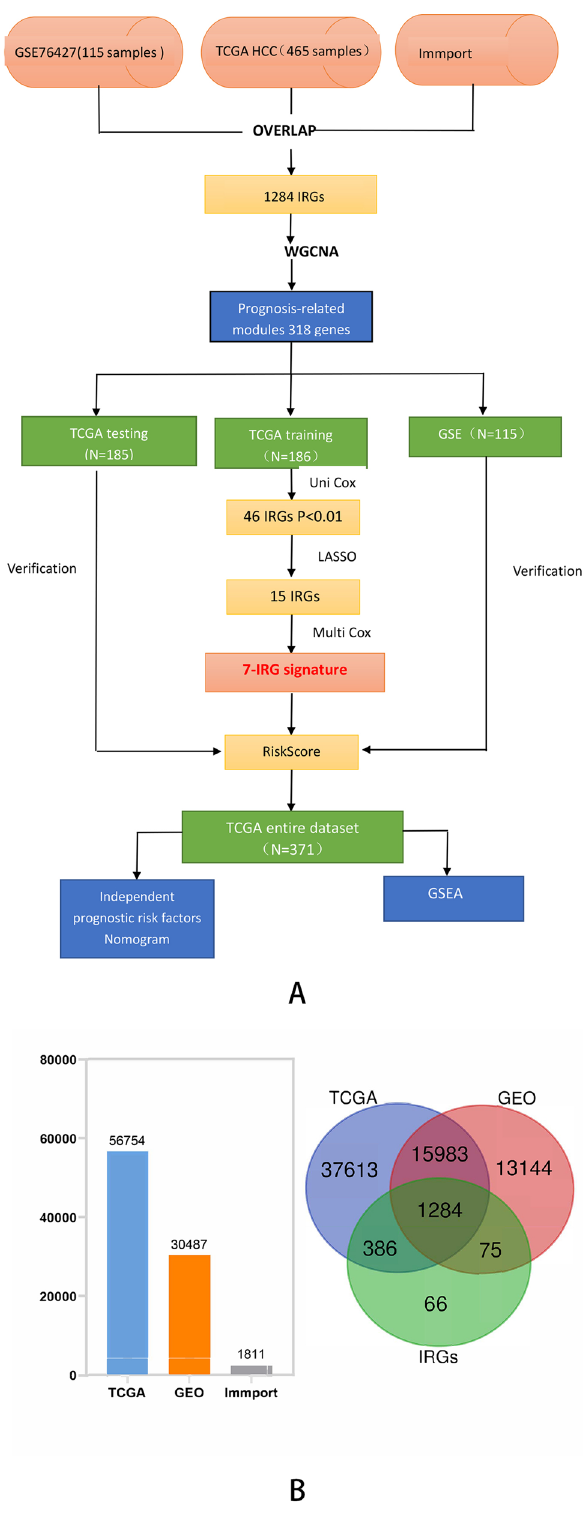
Figure 1. (A) Flow chart of the present study. (B) The common IRGs were visualized by Venn diagram and